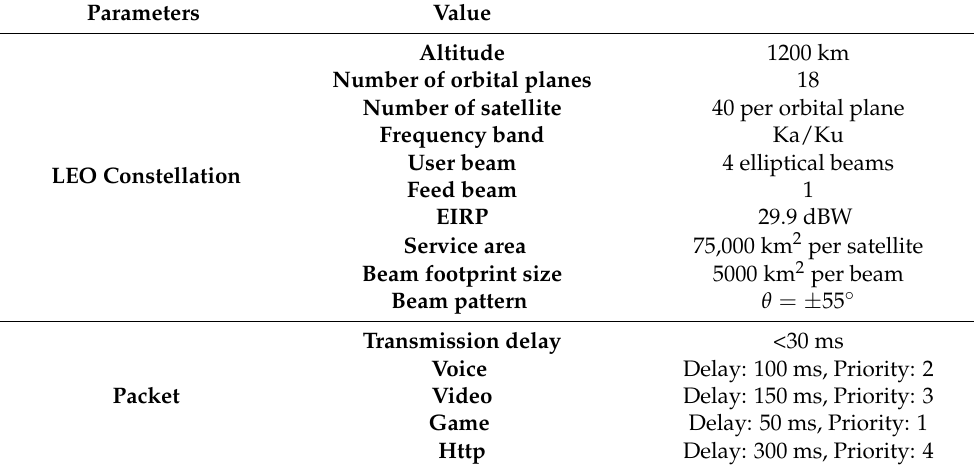
Table 1. The simulation